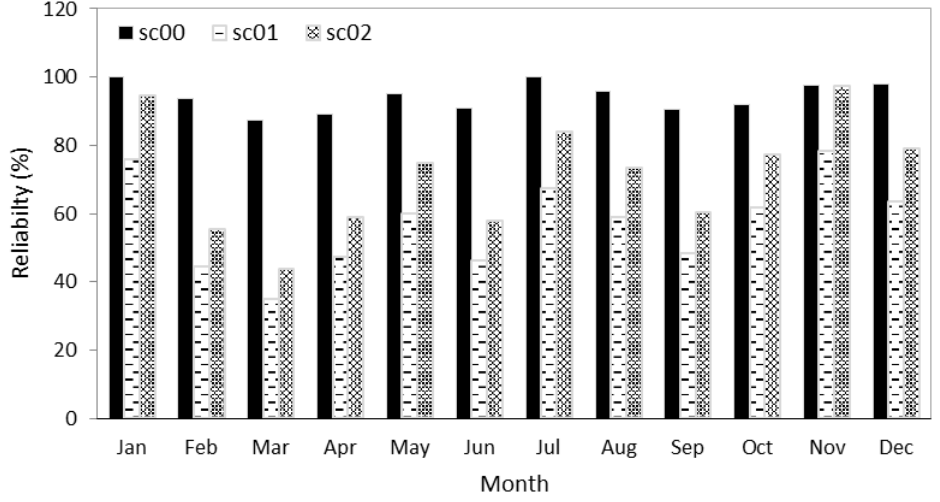
Figure 10. Water use reliability for the three scenarios for Sebwe.